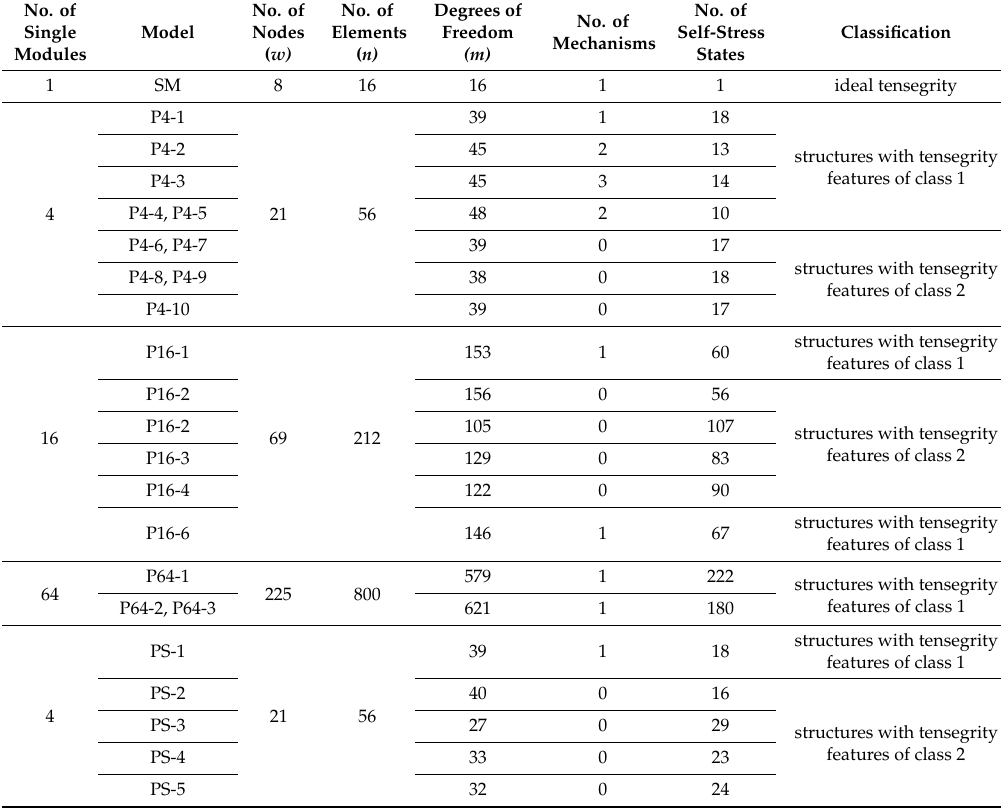
Table 4. Results of the qualitative analysis of the structures built with the modified Quartex modules. No. of